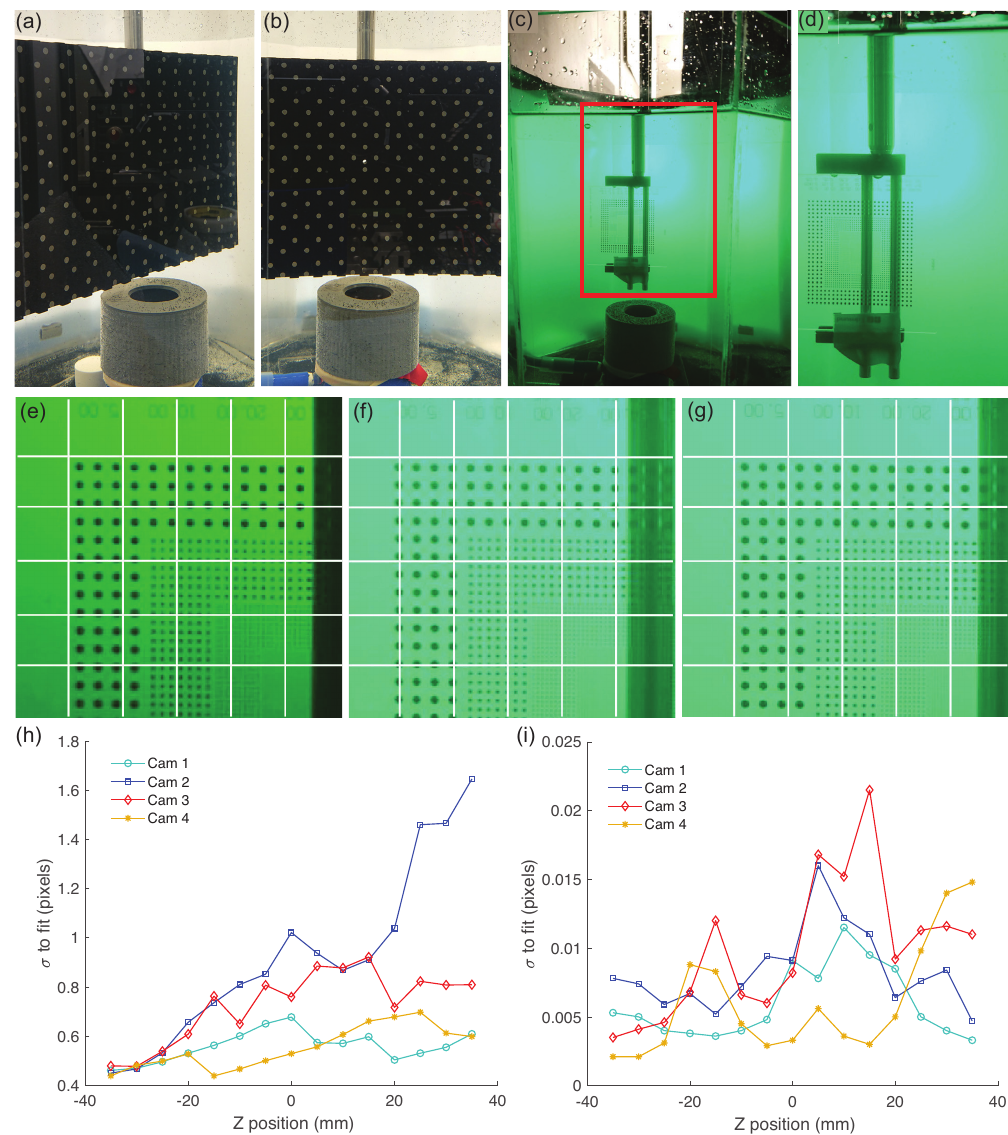
Figure 4. ( a , b ) Smartphone images captured in the manual mode for the calibration plate at z = 0 mm by ( a ) left camera, phone 1, and ( b ) central bottom camera, phone 3. The gray cylinder at the bottom is the vortex ring generator. ( c , d ) Top central camera, phone 2, view of a dotted calibration target located at the central plane of the vortex ring. ( c ) Captured with manual settings at 19 Mpx resolution. ( d ) Image of 2 × 2 binned image from 19 Mpx resolution and centered cropped to 1280 × 720 pixels (see the red region in ( c )). ( e – g ) Region of Interest (ROI) zoom (253 × 247 pixels) from the dotted calibration target. ( e ) High-speed video recording mode, ( f ) centered binning of 2 × 2 with top left corner located at x = 624 and y = 588 px (centered down-scaled image) ( g ) Binning of 1.9267 × 1.9267 with top left corner located in x = 648 and y = 590 px of the binned image. A rectangular grid is shown for comparison. ( h ) Initial standard deviation of the calibration fit. ( i ) Final calibration standard deviation after three iterations of the self-calibration